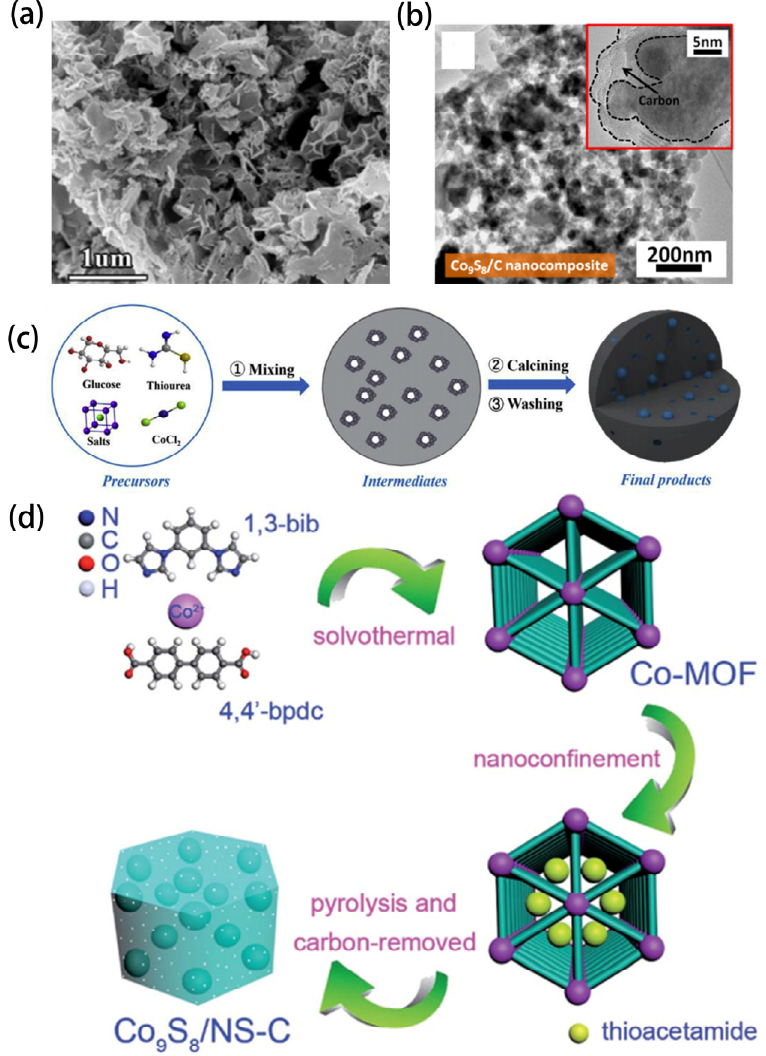
Figure 2. ( a ) SEM images of Co 9 S 8 /C-T precursor. Reprinted with permission from Reference [19].